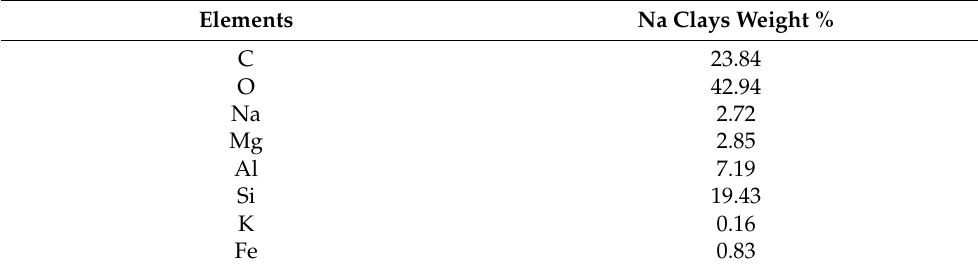
Figure 4. Representative transmission electron microscopy images at different magnifications ( a – d ) of Na clays. Table 2. EDAX data for Na clays.